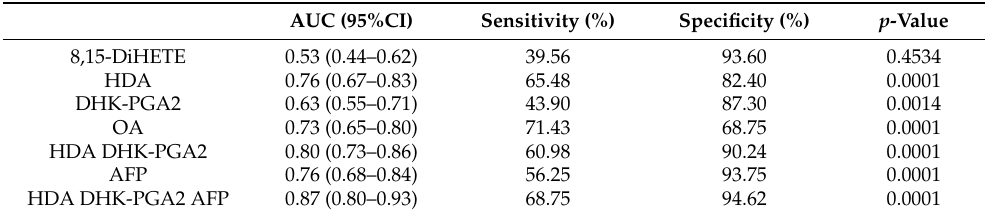
Table 4. The diagnostic performance of the following indicator and their combination for the detection of T2DM(+) HCC from the T2DM population.